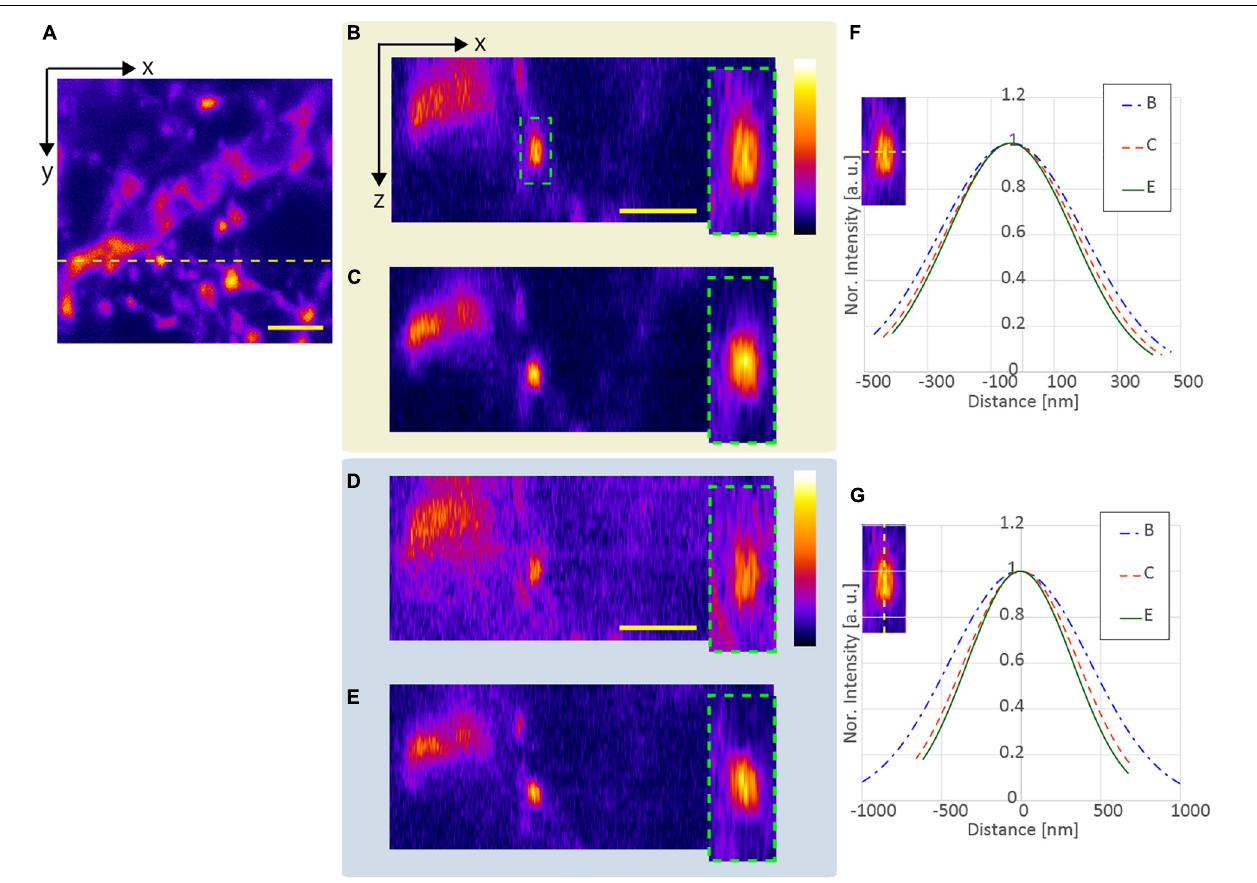
FIGURE 9 | Observation result of the YFP mouse brain at an optical depth of 75.5–81.9 µ m. (A) x-y stacked image obtained using the APV excitation beam. The x-z images on the yellow dotted line (panel A ) when using the (B) APV excitation beam without SA correction, (C) APV excitation beam with SA correction, (D) AMAPV without SA correction, and (E) AMAPV with SA correction. (F) Gaussian fitting results in the lateral direction. (G) Gaussian fitting results in the axial lateral direction. The excitation beam intensity under the objective lens was (B,C) 144 and (D,E) 162 mW. Scale bar: 3 µ